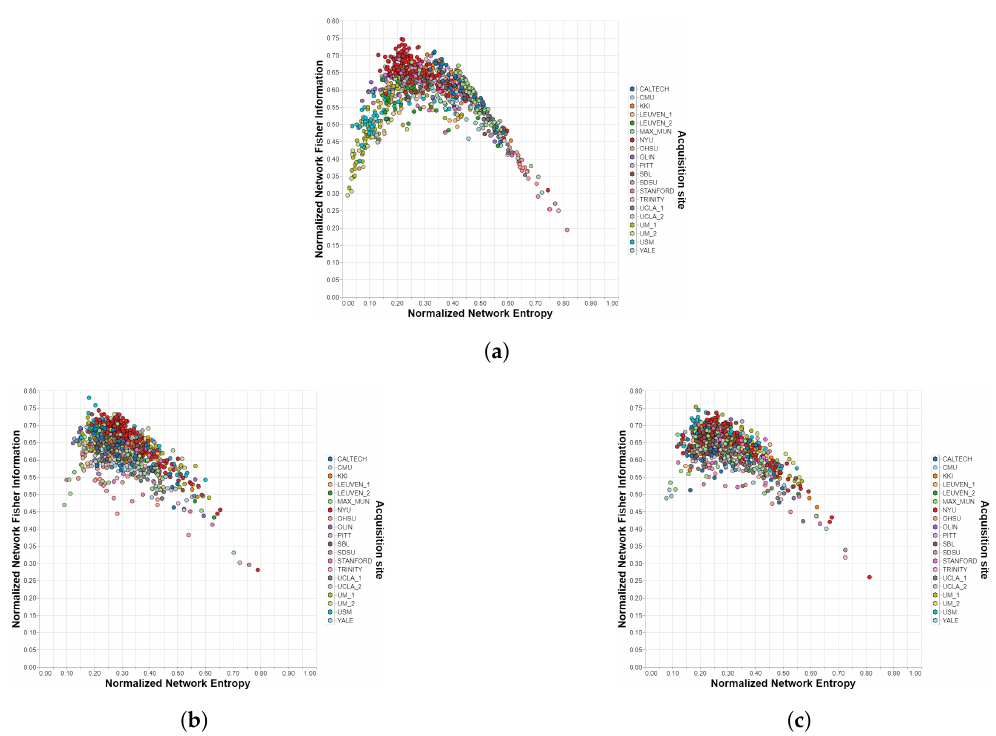
Figure 5. Shannon − Fisher planes for ABIDE/Dosenbach with different harmonization methods. Each point corresponds to a different subject in the dataset and each color to a different acquisition